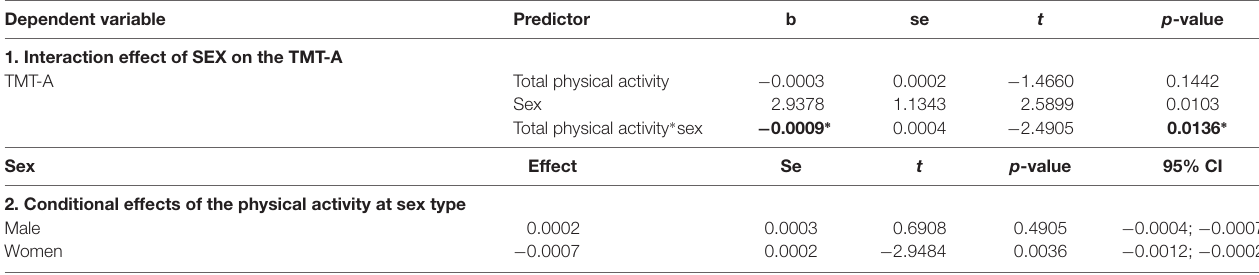
TABLE 4 | Moderating effect of sex on the relationship between the physical activity and